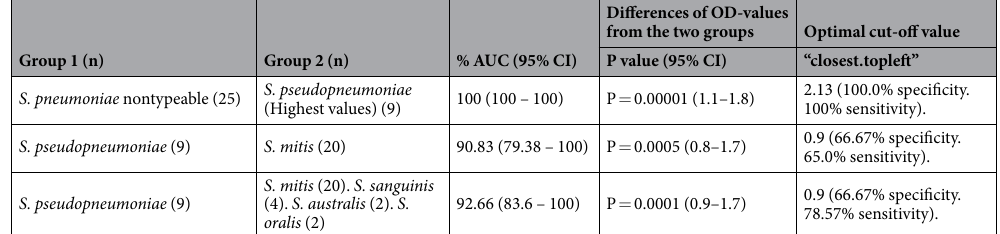
Table 3. Area under the curve (AUC) and the optimal cut-off values calculated by using “closest topleft”.